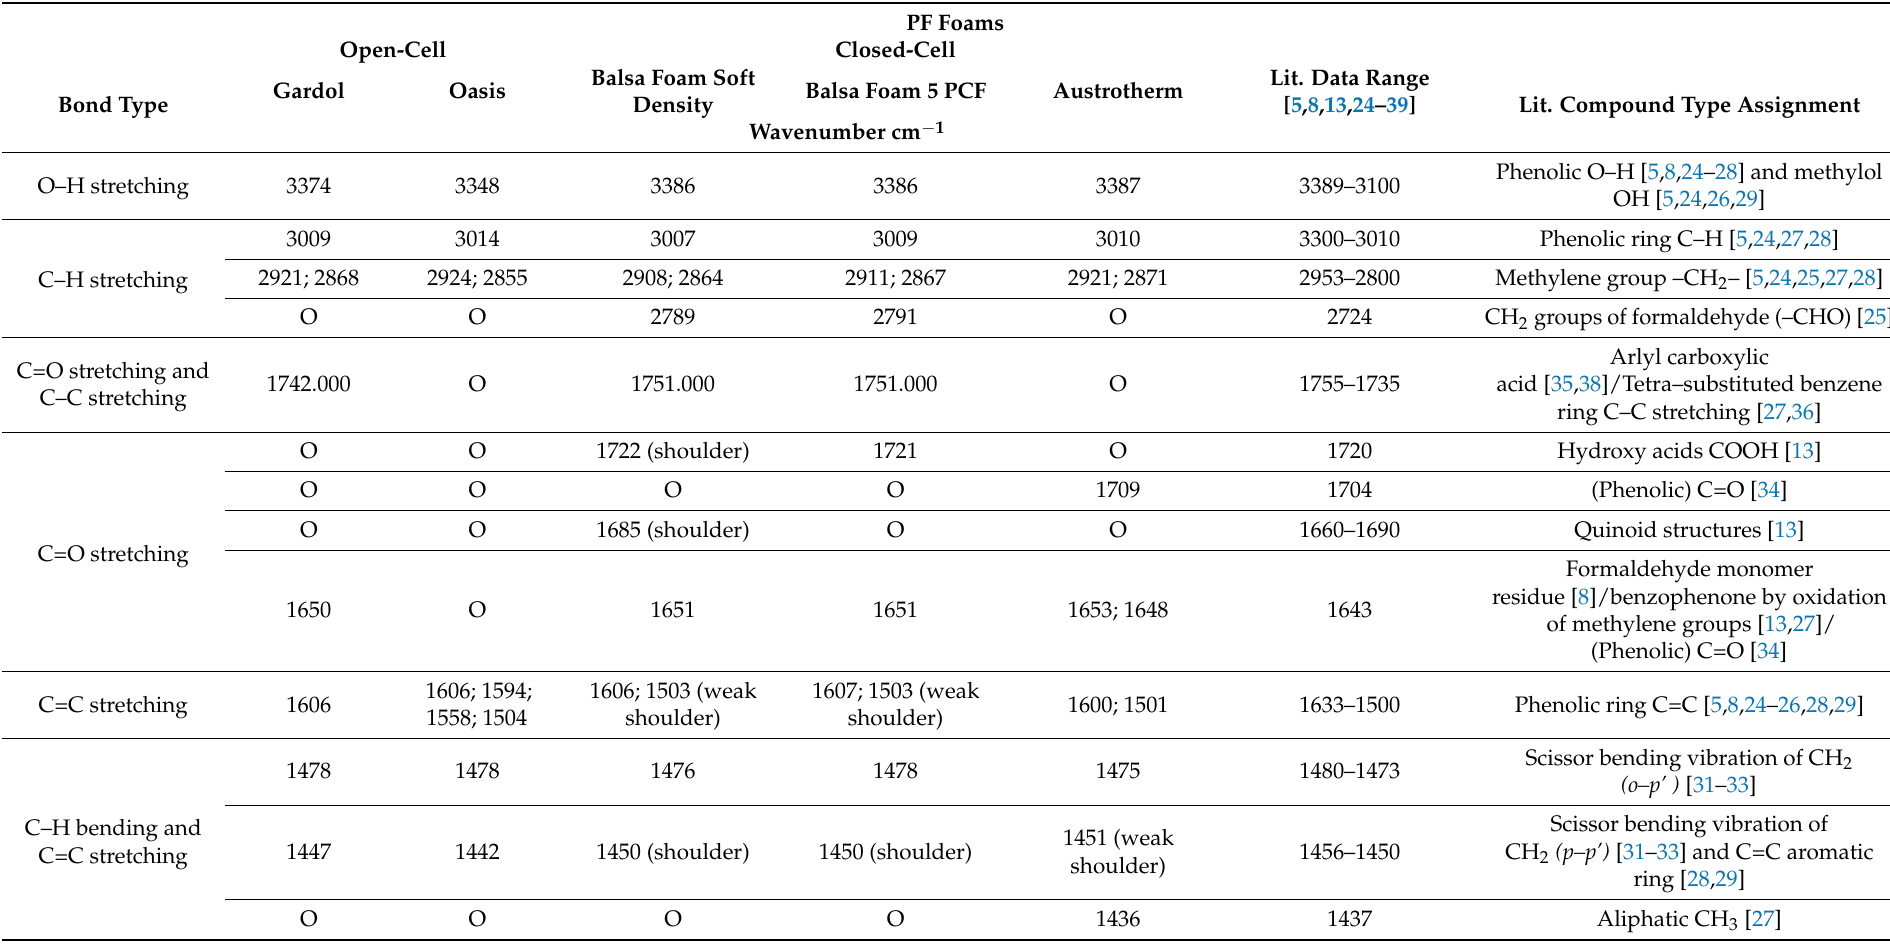
Table 3. µ -FTIR absorptions of the open- and closed-cell “Unaged” phenol formaldehyde (PF) foams investigated and their assignment according to the literature data